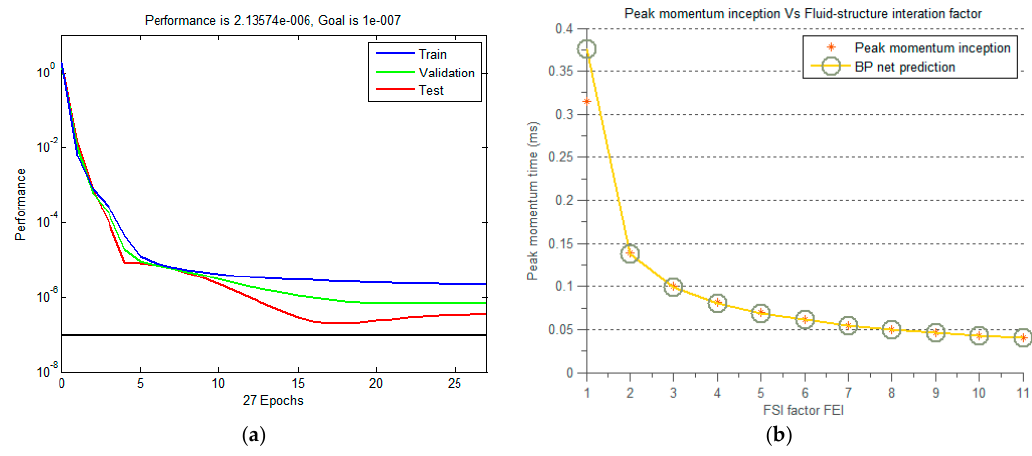
Figure 9. Training process performance curve ( a ) and comparison of the peak momentum time τ P with the prediction results ( b ).